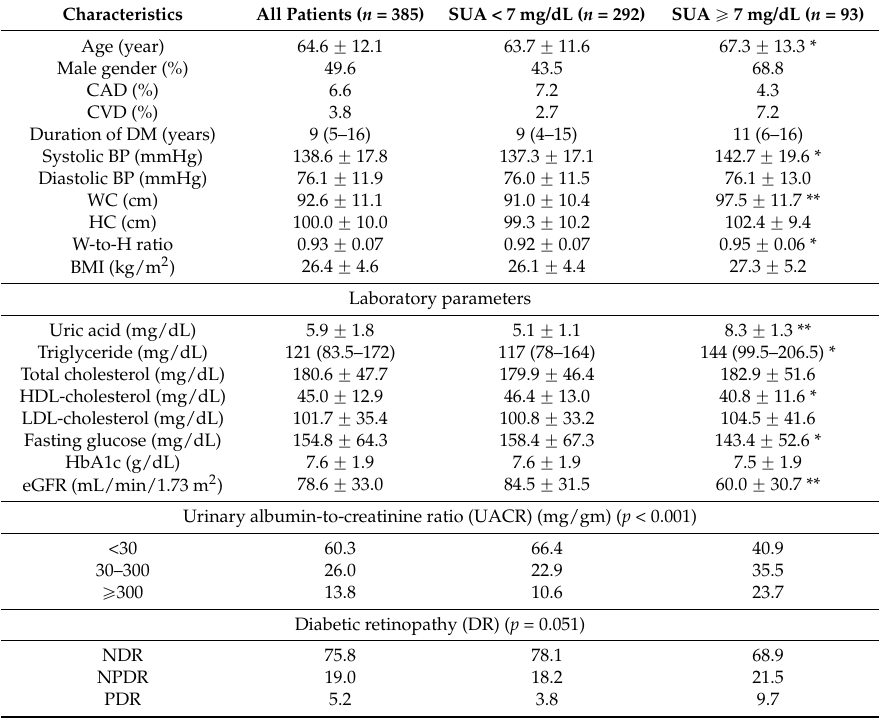
Table 1. Comparison of clinical characteristics between patients with serum uric acid (SUA) <7 and ě 7 mg/dL.